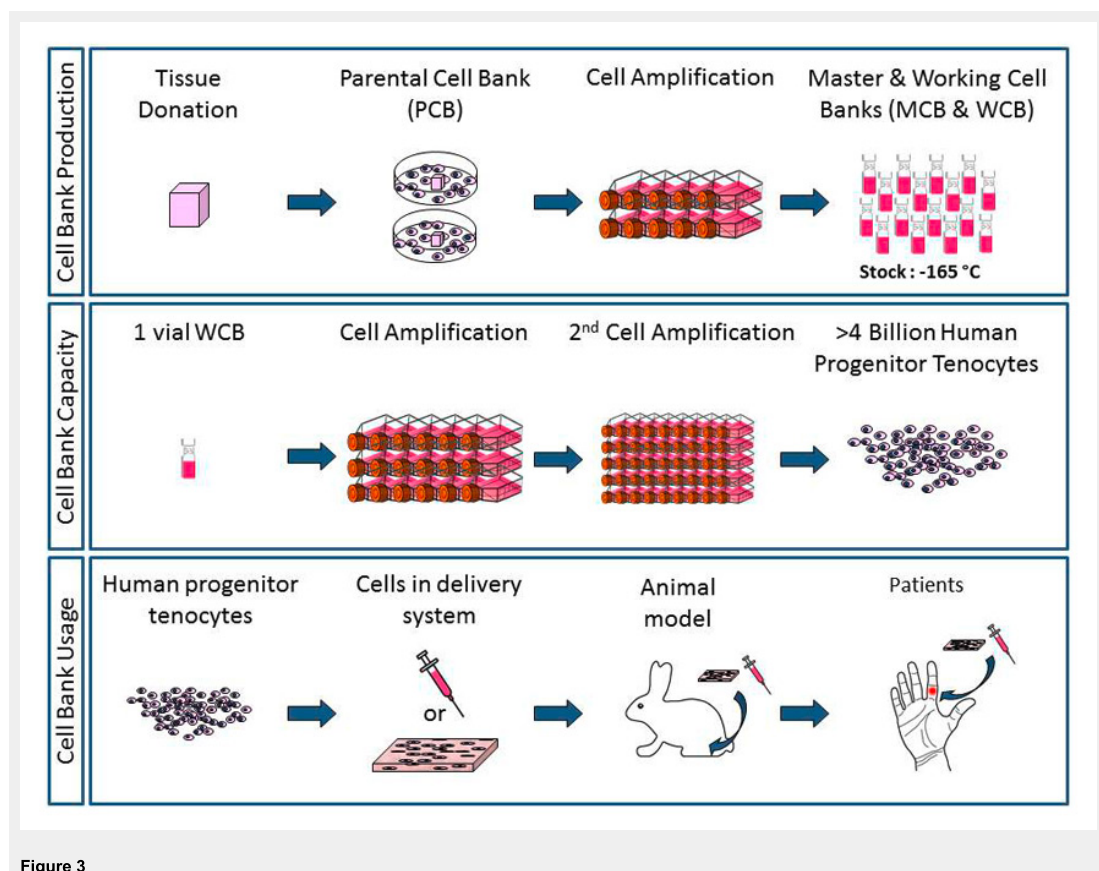
Figure 3 Progenitor human tenocyte cell bank production, capacity and usage for off-the-shelf therapeutic options for tendinopathies. From one single tendon tissue (2 mm 3 , organ donation of foetal Achilles tendon tissue at 14 weeks gestation), clinical cell banks can be produced including parental primary cultures, Master and Working Cell Banks that contain 200 vials each of progenitor tenocytes at low passages (P. 3–6). Expansion of cells produces high quantities of cells that can be stocked in vapor phase of liquid nitrogen (–165 °C) providing cell stocks for hundreds of thousands of patients. Cells can be administered in hydrogels or on other delivery systems for testing in animal models and pre-clinical patient treatments in the process for therapeutic agent